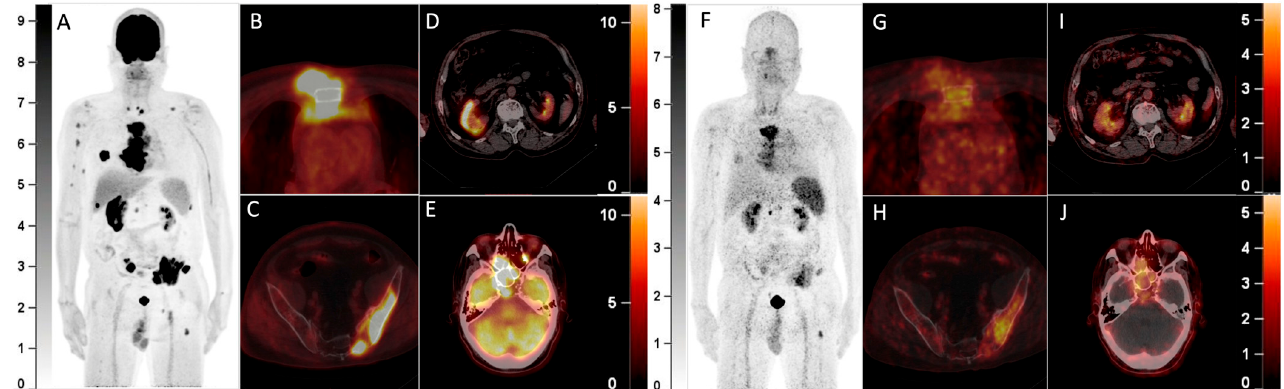
Figure 1. A 64-year-old man with a history of multiple myeloma (MM) for 8 years, recently presented with a parasternal mass and blindness of the right eye. Serum protein electrophoresis and immunofixation electrophoresis showed positivity for the monoclonal protein (16.2 g/L, IgA ‐λ ). A biopsy of the parasternal mass confirmed plasmacytoma. Considering the recurrence of MM, 18 F-FDG PET/CT was referred. The maximum intensity projection (MIP) of the PET ( A ) detected multi-foci with intense radioactivity all over the body. The axial fusion images ( B , C , bone window) showed most of the FDG-avid foci were located in bone marrow, most prominently in the sternum and pelvis (SUVmax 34.0), accompanied by lytic bone destruction and paramedullary masses. Additionally, the axial fusion images ( D , E , soft tissue window) demonstrated extramedullary disease (EMD) with intense FDG uptake in the right kidney and paranasal sinus (SUVmax 22.3), which also involved the right orbit and temporal lobe. Since 68 Ga-Pentixafor has been reported to be advantageous over 18 F-FDG in assessing MM 1,2 , he was included in the clinical trial of 68 Ga-Pentixafor (NCT03436342). In the MIP ( F ) and corresponding axial fusion images of 68 Ga-Pentixafor PET ( G – J ), the above hypermetabolic foci showed significantly lower tracer uptake as compared with 18 F-FDG PET (bone marrow lesions: SUVmax 16.5; EMD: SUVmax 7.4).